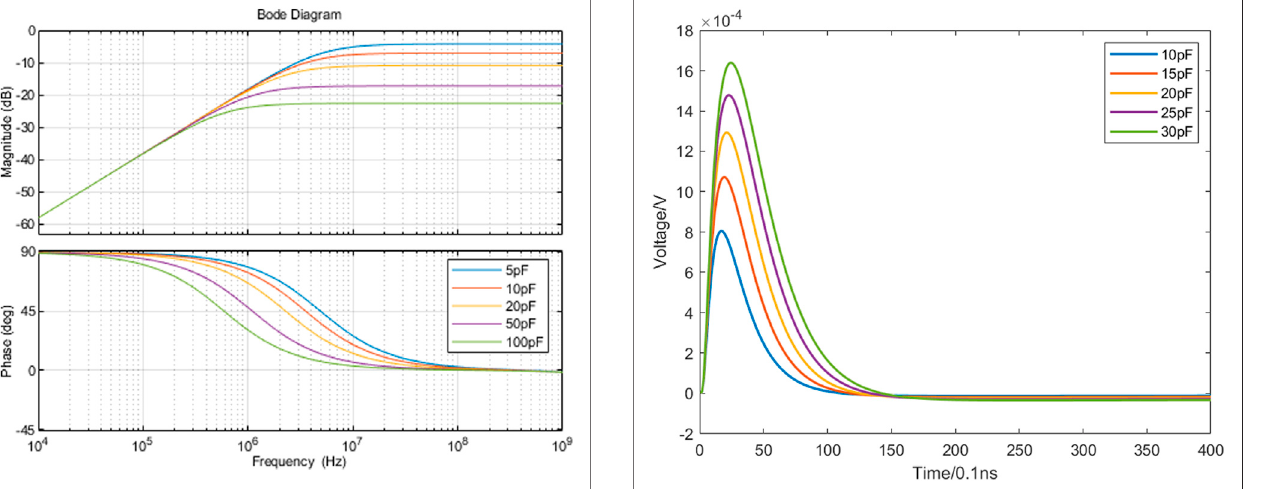
FIGURE 11 | Frequency response with different stray capacitance.